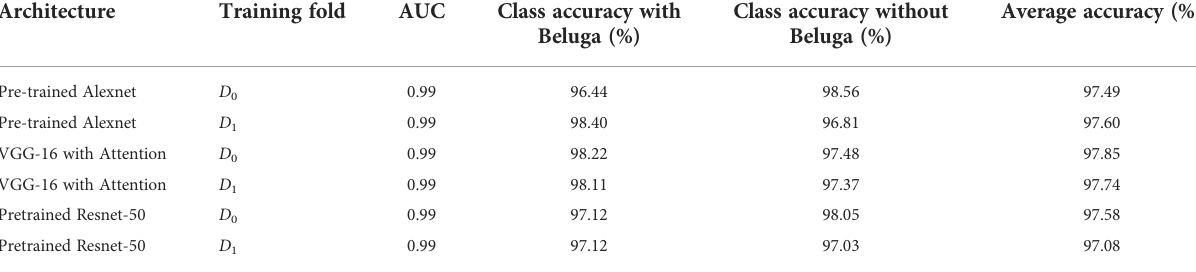
TABLE 4 Results summary for three CNN architectures: Alexnet, VGG-16, and ResNet-50.